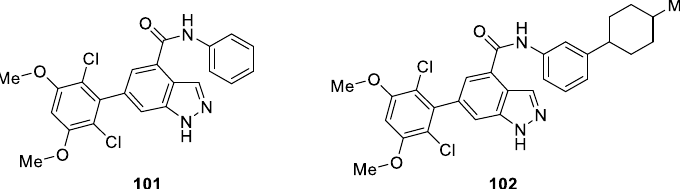
Figure 15. Chemical structures of 6-(2,6-dichloro-3,5-dimethoxyphenyl)-4-substituted-1 H -indazole derivatives 101 and 102.